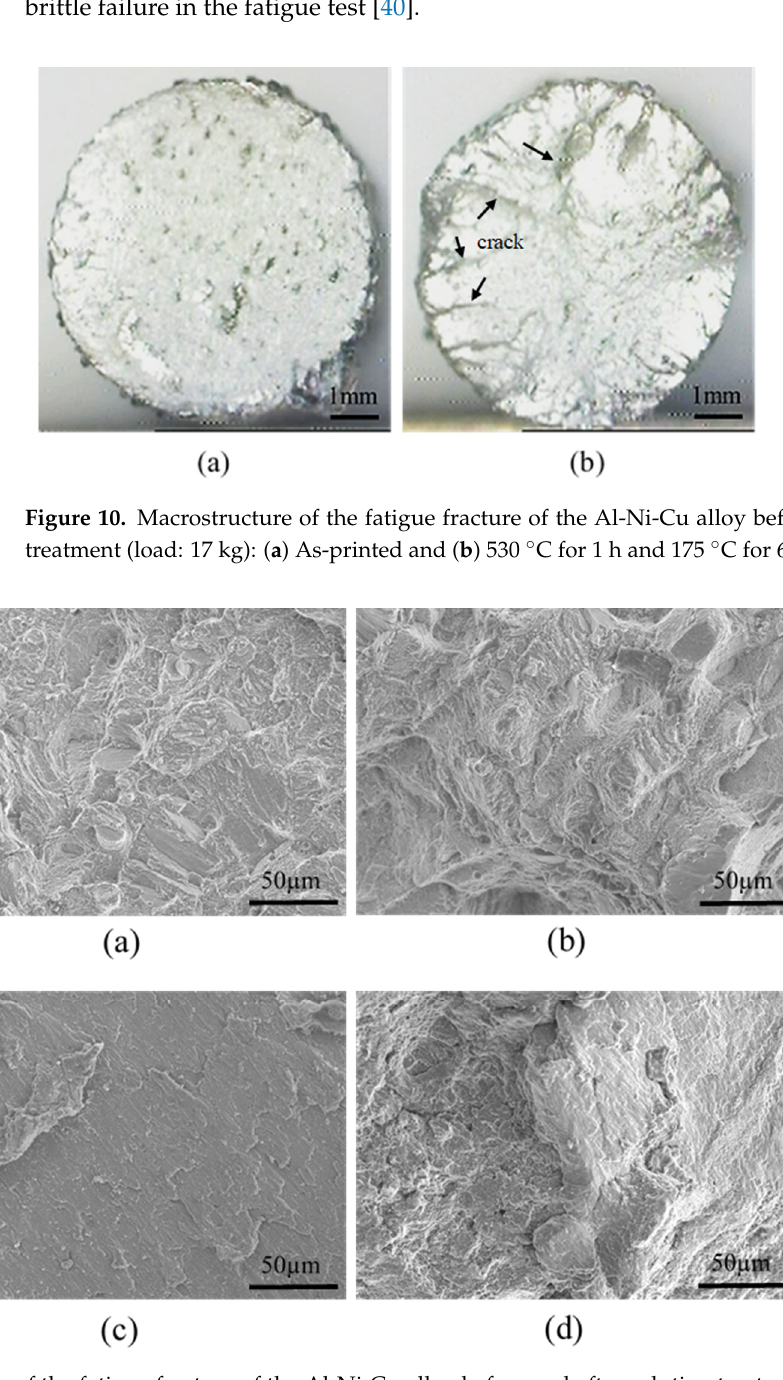
Figure 11. Microstructure of the fatigue fracture of the Al-Ni-Cu alloy before and after solution treatment (load: 17 kg): ( a ) crack propagation region of As-printed, ( b ) final crack region of As-printed, ( c ) crack propagation region of 530 ◦ C for 1 h and 175 ◦ C for 6 h, and ( d ) final crack region of 530 ◦ C for 1 h and 175 ◦ C for 6 h.